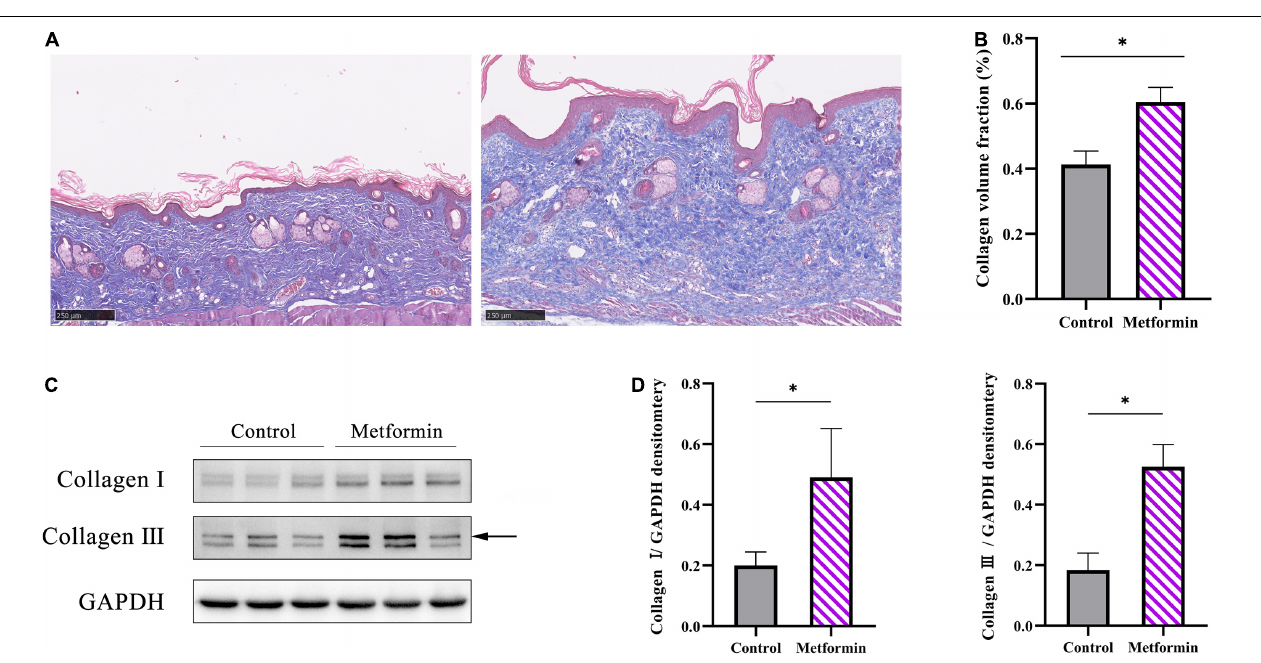
FIGURE 3 | Evaluation of collagen synthesis. (A) Masson’s trichrome staining showed increased collagen deposition in the metformin-treated group, with (B) a significantly higher CVF than the control group. (C) Western blot analysis and (D) quantification of collagen I and collagen III expressions. ∗ p <